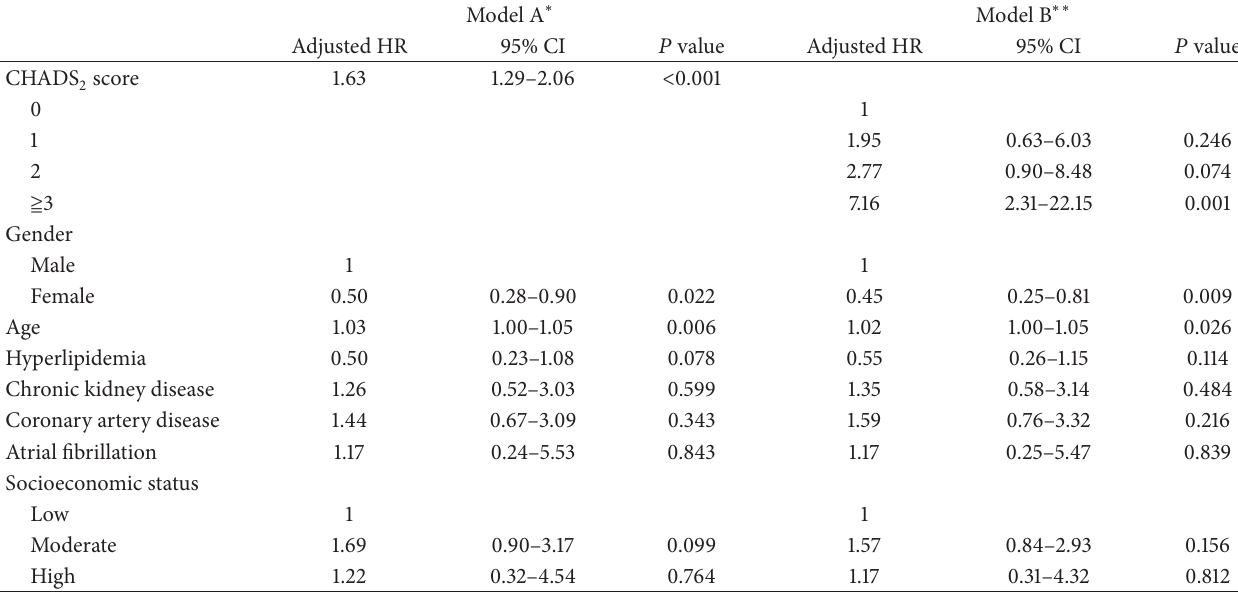
score for MACEs in patients with Cushing’s syndrome ( 𝑛 = 551 ). 2